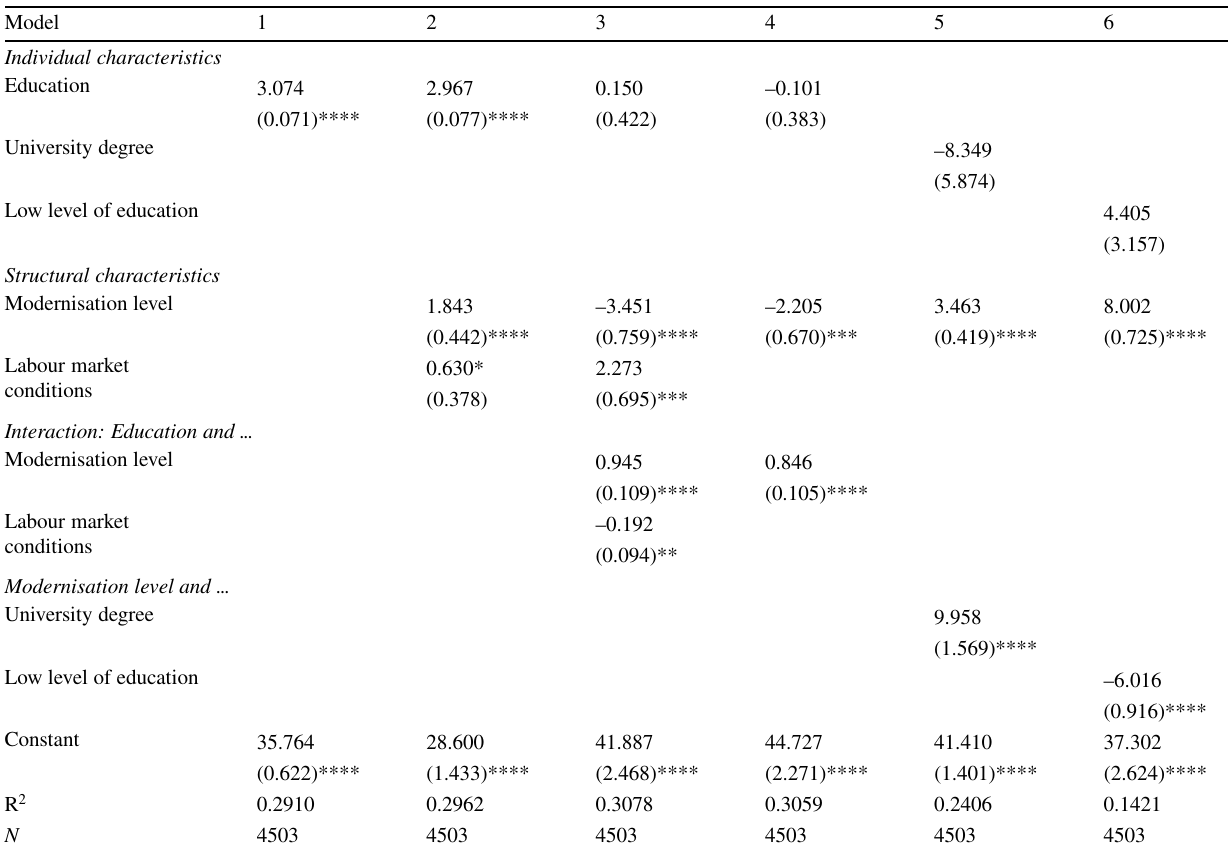
Table 3 Job prestige at the time of entry into the labour market (first